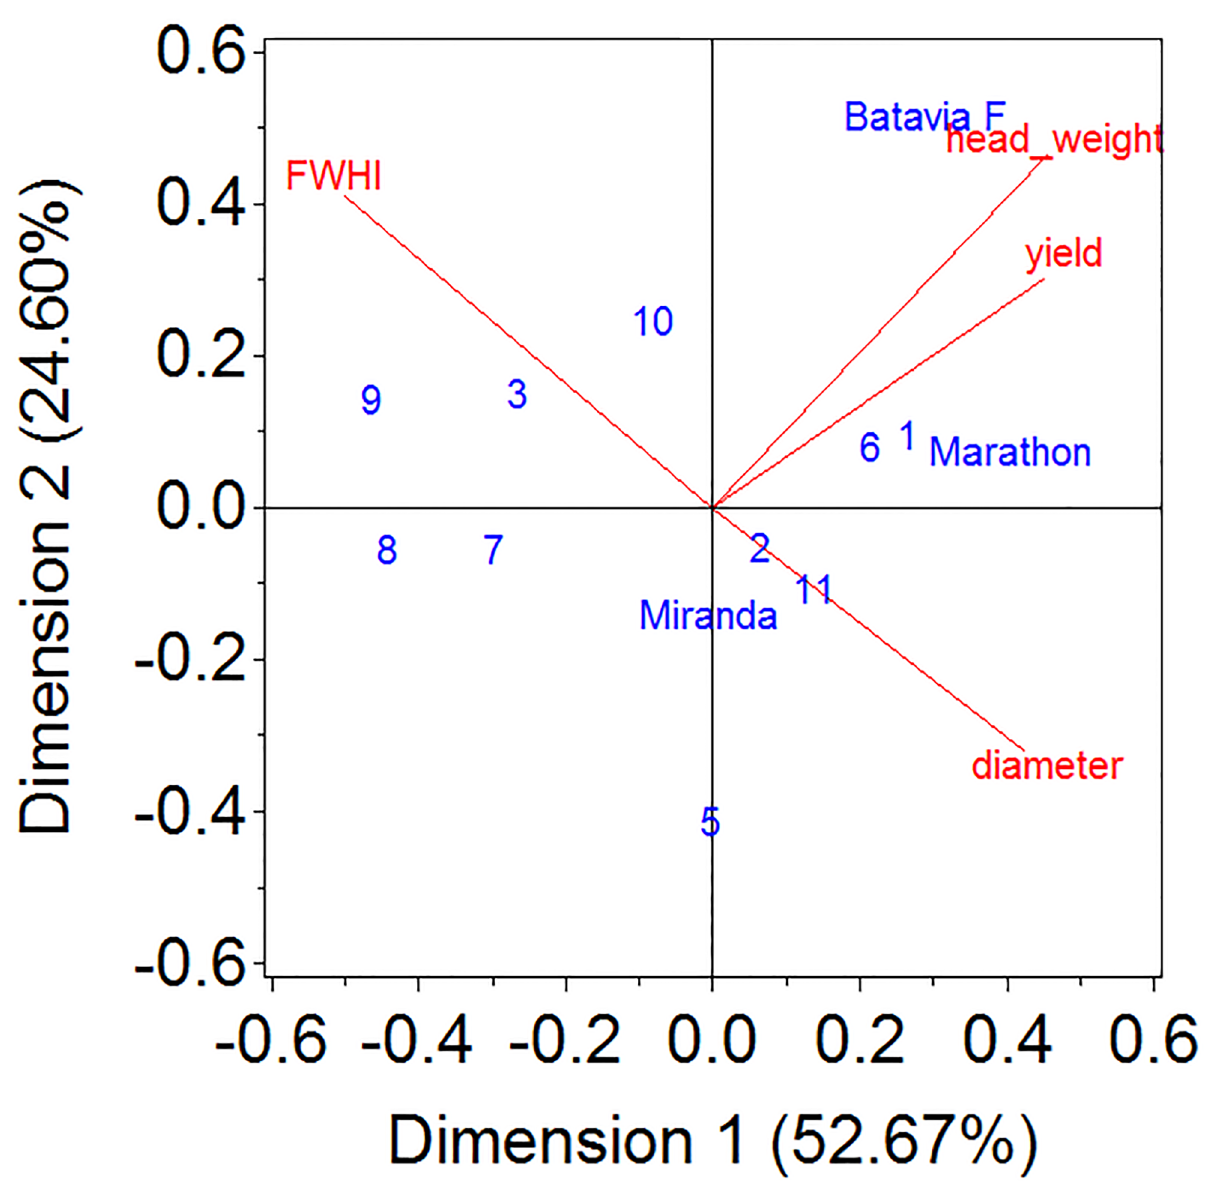
Fig 2. Biplot of genotype-by-trait means across growing seasons. Arrows denote traits, lines names denote experimental lines. 1: CHE-BAL-A, 2: CAN-SPB, 3: Calinaro, 4: TH-COA, 5: CHE-GRE-A, 6: CHE-GRE-G, 7: TH-LIM-19-28, 8: TH-LIM-20-68, 9: Line 124, 10: Line 701, 11: CHE-MIC.